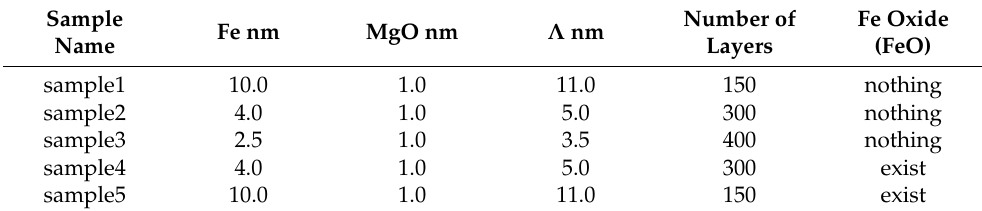
Table 1. Fabricated samples for